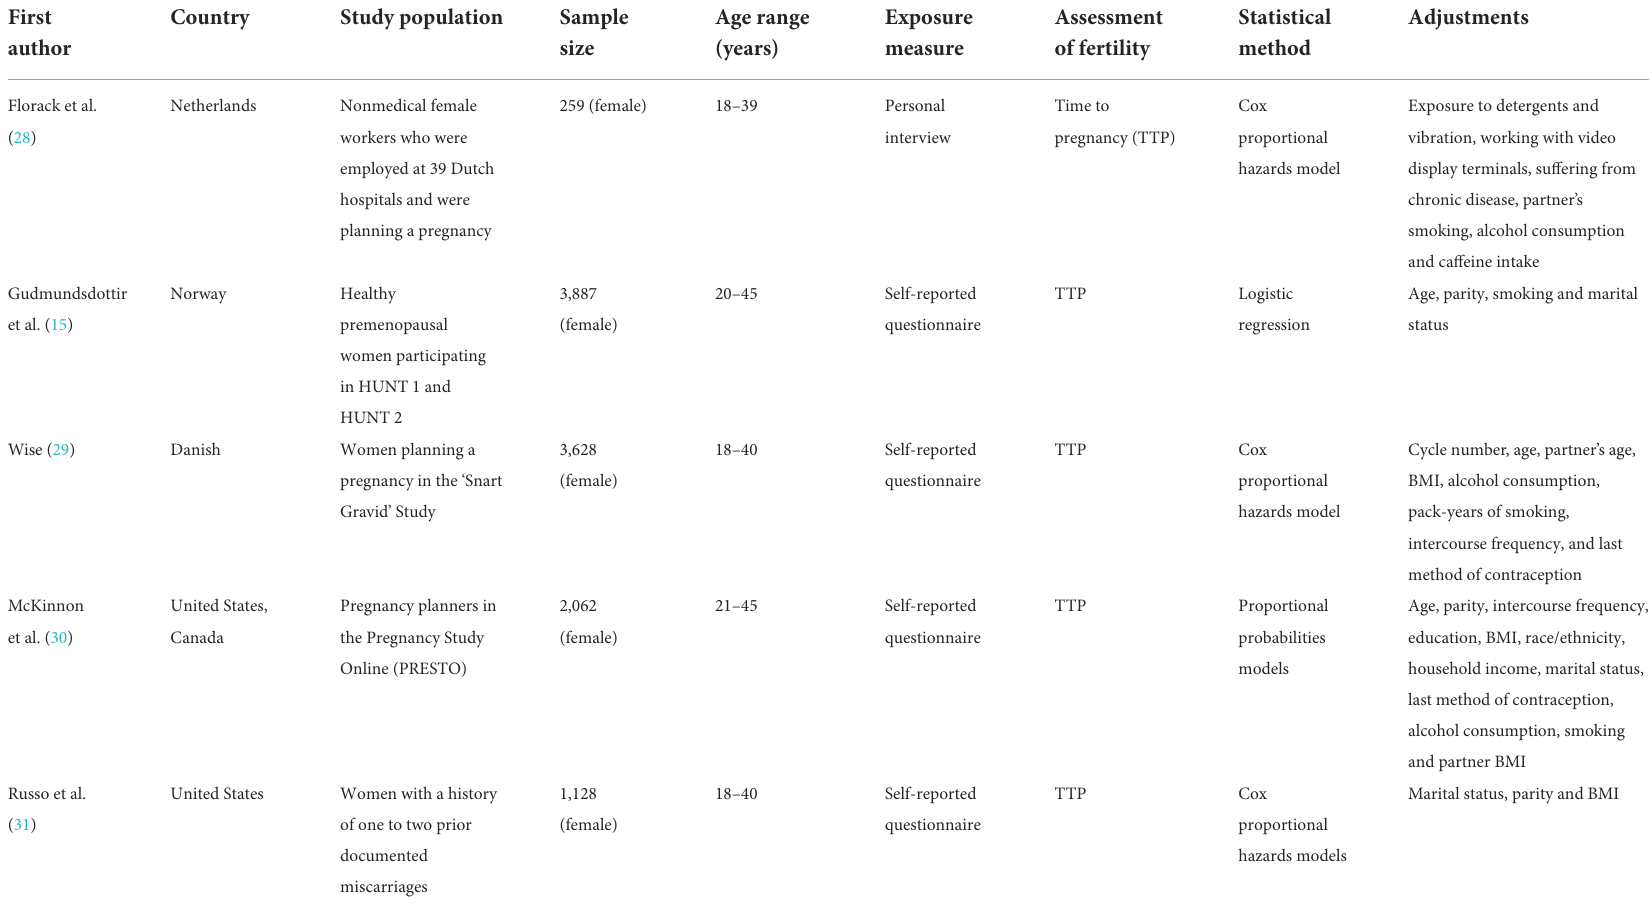
TABLE 1 Characteristics of selected